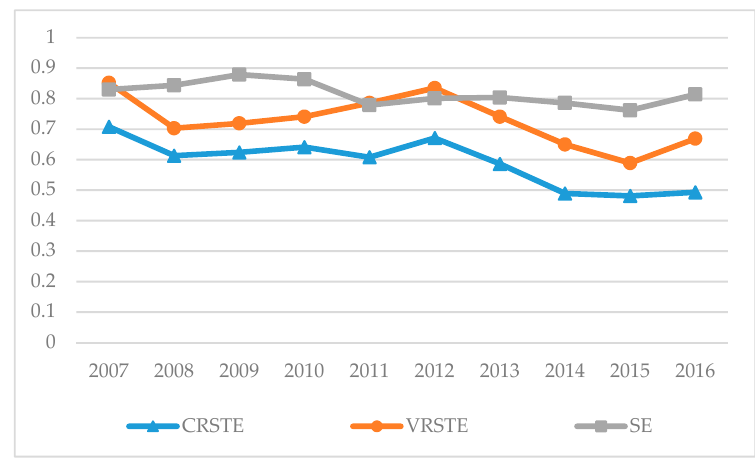
Figure 1. Decomposition of EGE in the Yangtze River urban agglomeration.